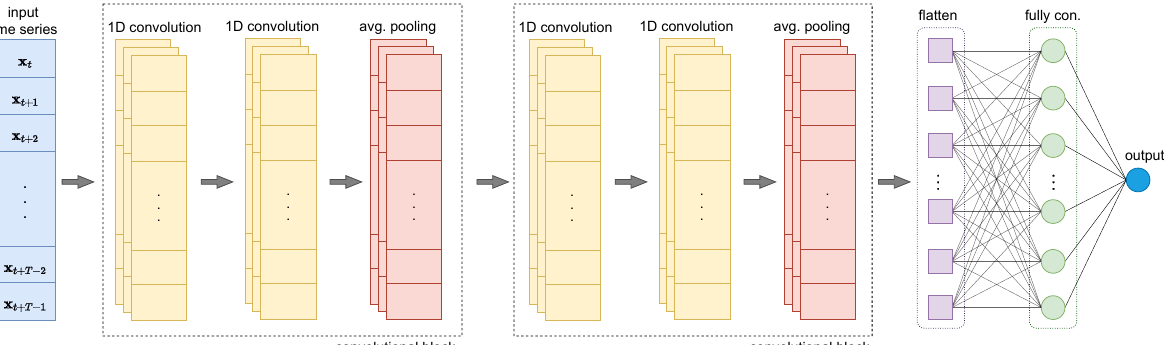
Figure 6. The 1D convolutional neural network architecture with two convolutional blocks. Depend- ing on the anomaly detector type, input time series are either univariate or